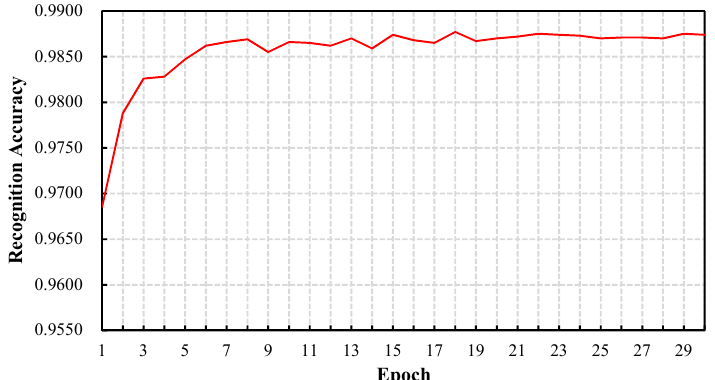
Figure 11. Recognition effect on the validation set.